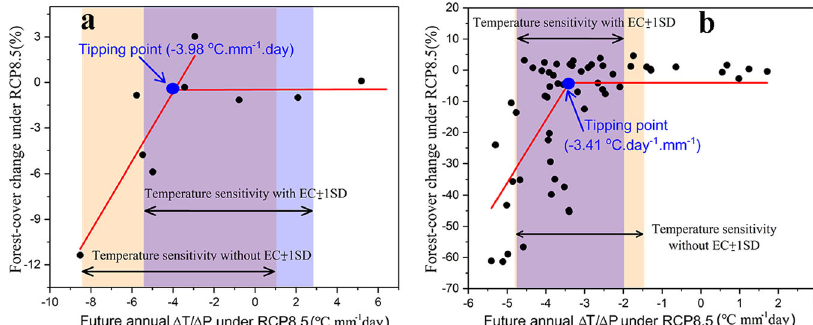
Fig. 3 Estimating future potential forest losses using the constrained temperature sensitivity. The relationships between the future forest losses (difference in forest-cover fraction between the periods 2089 – 2098 and 2006 – 2015) and the future annual temperature sensitivity for the CMIP5 ( a ) and HadCM3 ( b ) model ensembles under RCP8.5. The light blue bar is the constrained temperature sensitivity ± standard deviation ( − 1.49 ± 2.18 °C mm − 1 day). The light brown bar is the initial mean temperature sensitivity of the CMIP5 models ± standard deviation ( − 3.61 ± 4.69 °C mm − 1 day). The red lines before the tipping point are the mean future forest losses. The red lines after the tipping points are the linear relationships between the future forest losses and the future annual temperature sensitivities for the CMIP5 models ( y = (2.280 ± 0.58) x + 8.45, p < 0.001, R = 0.89, for ( a )) and for the 57 HadCM3 model runs ( y = (20.08 ± 6.3) x + 64.31, p < 0.001, R = 0.53, for ( b )). Note: Among the 29 CMIP5 models, 12 models output the leaf area index (LAI). Among them, we ignored the outputs of the LAI from the MIROC-ESM, GFDL-C3 and GFDL-ESM2G models, because of the unexpected result that for these three models, the more negative temperature sensitivity is, the higher is the LAI. This is not realistic because more negative temperature sensitivity represents a higher land surface temperature (see Methods for calculating forest-cover fraction using the LAI